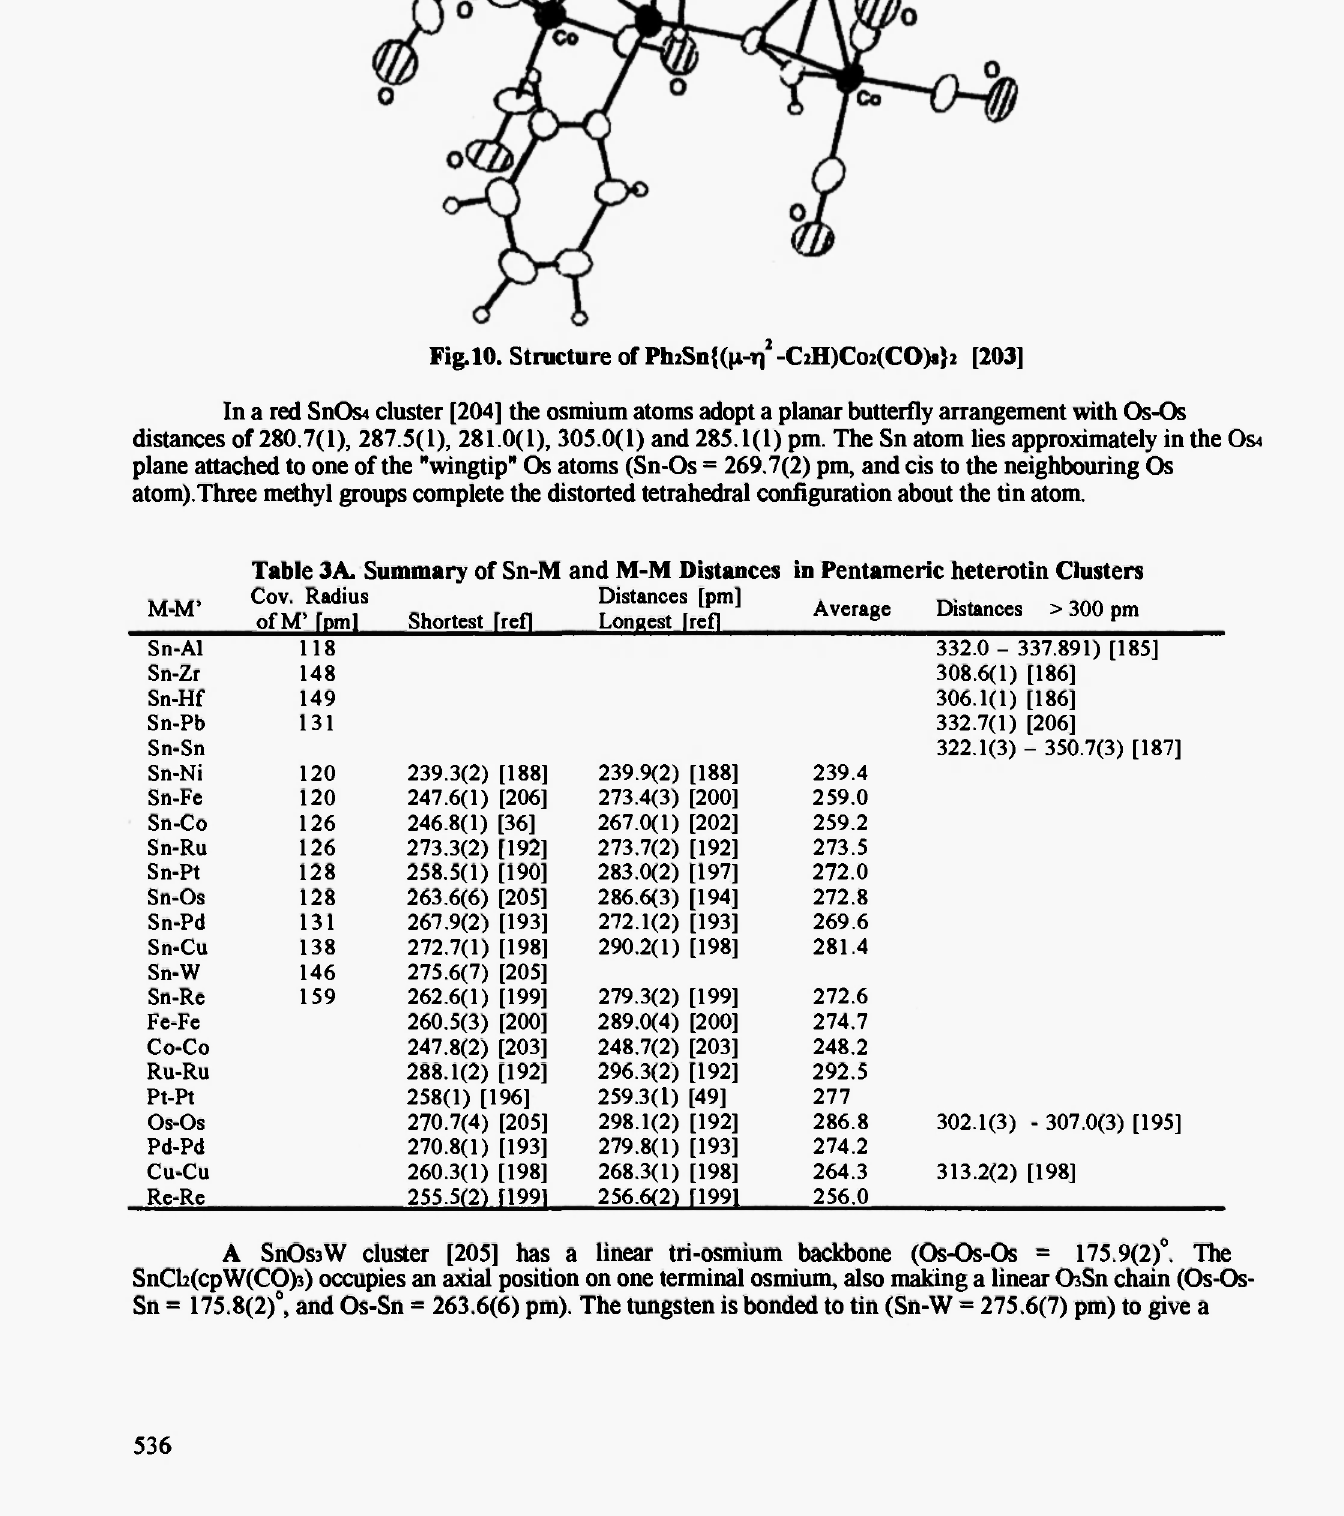
Fig. 10. Structure of Ρ1ΐ28η{(μ-η 2 -C2H)Co2(CO)s}2 [203]